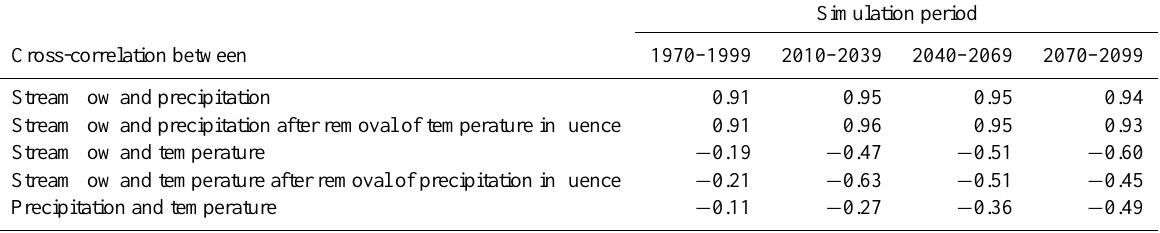
Table 2. Cross-correlations of average projected streamflow, precipitation and temperature for one historical and three future 30-yr periods.